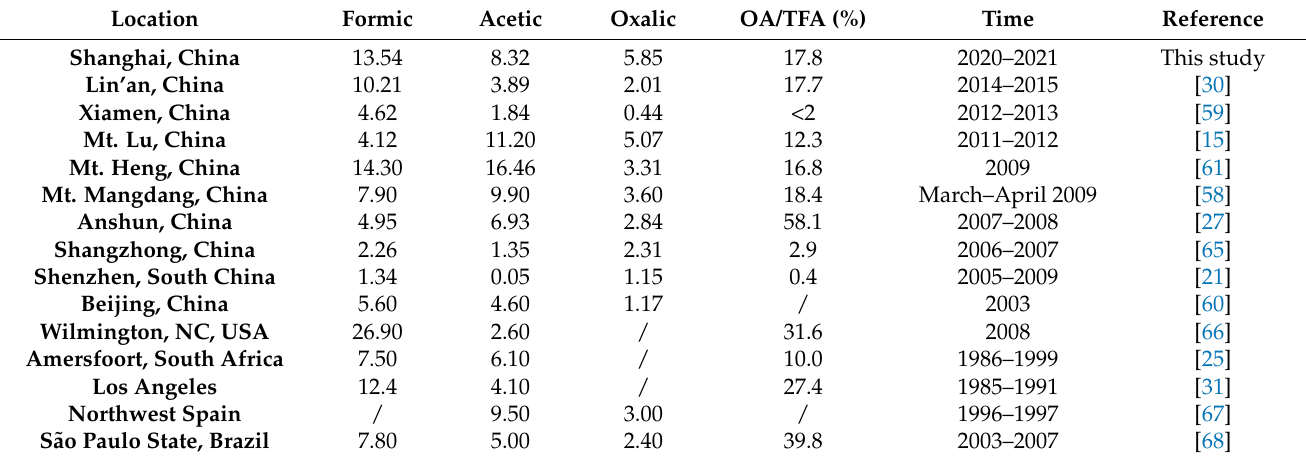
Table 1. VWM concentrations ( µ eq L − 1 ) of major organic acids, corresponding contributions of organic acids to the acidity in rainwater in different representative regions. Location Formic Acetic Oxalic OA/TFA (%) Time